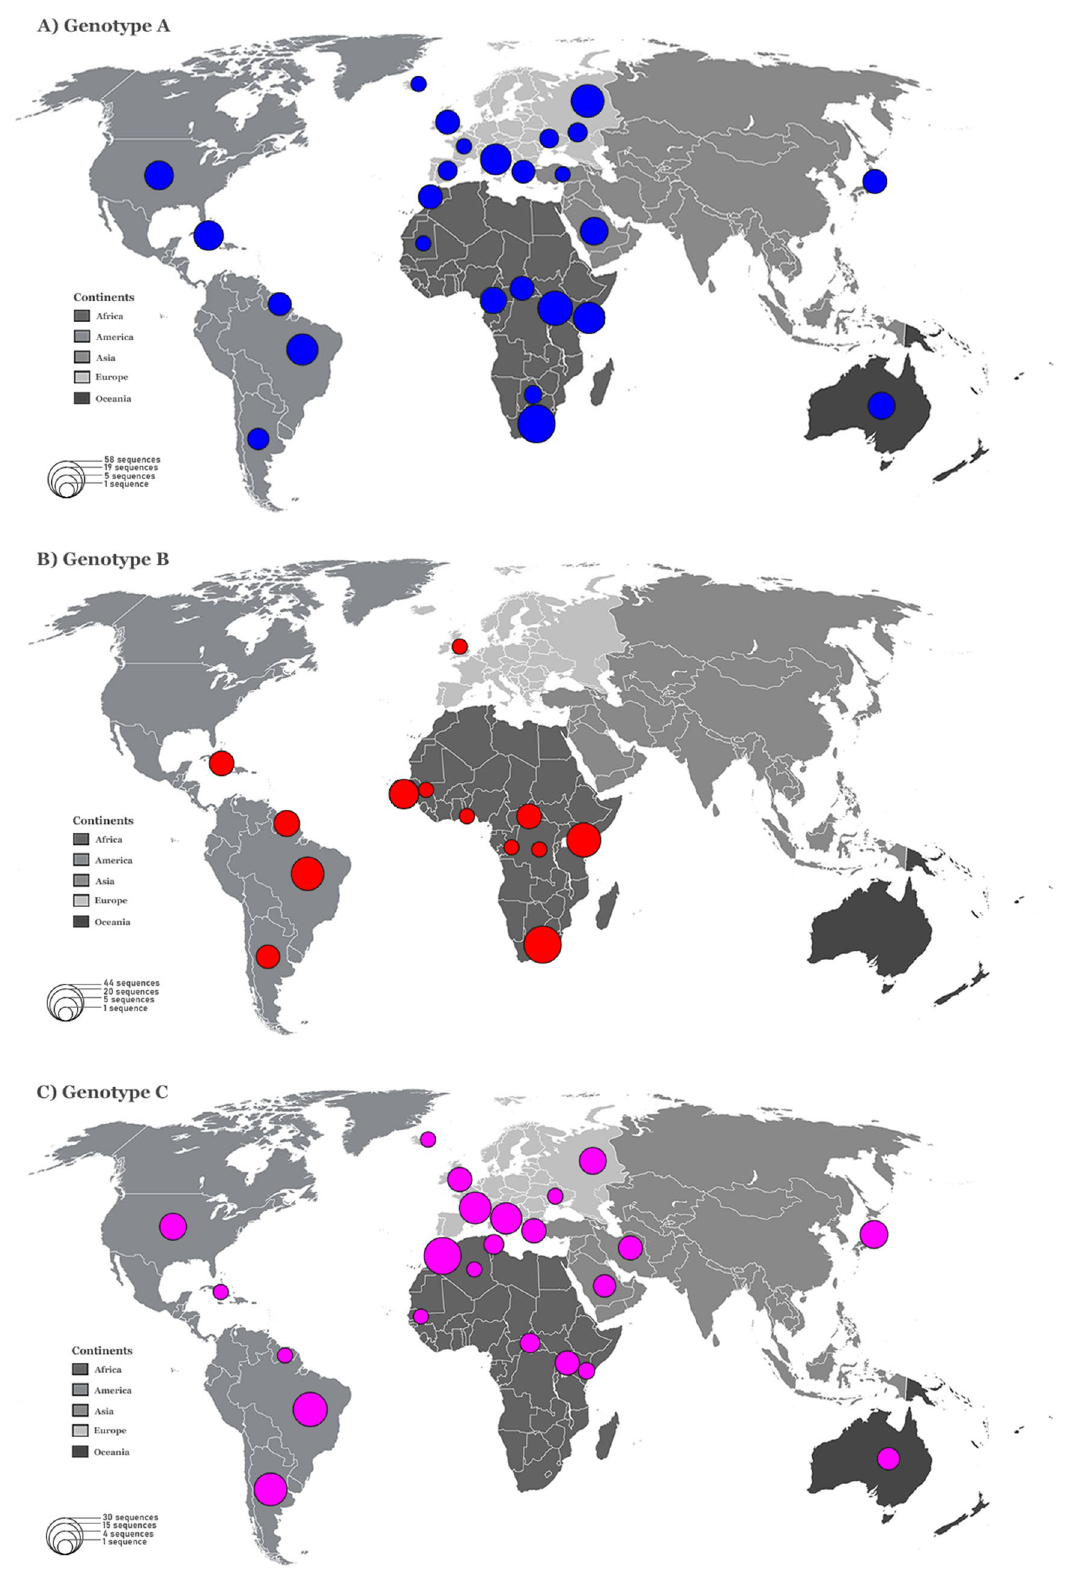
Figure 3. Global distribution of HHV-8 genotypes. The six world maps demonstrate the distribution of each HHV-8 genotypes ( A - F ). The genotypes and continents are indicated in the figure. Countries forming a continent are shaded in the same colour. The size of the circles is proportional to the number of HHV-8 ORF-K1 coding region sequences belonging to a particular origin analysed in this study. All sequences collected from